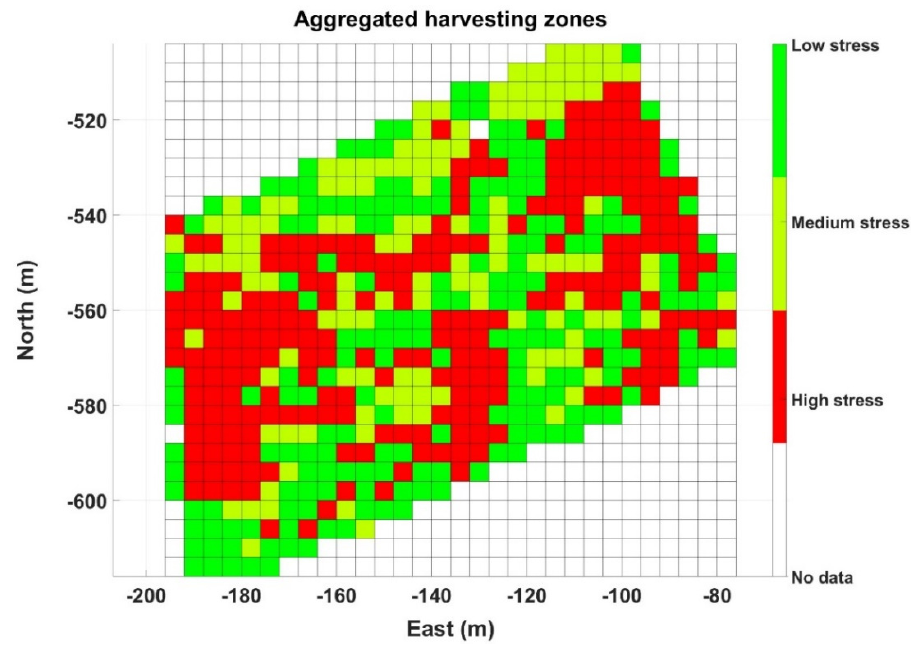
Figure 16. Aggregated map of harvesting zones integrating data from seasons 2019 and 2020.